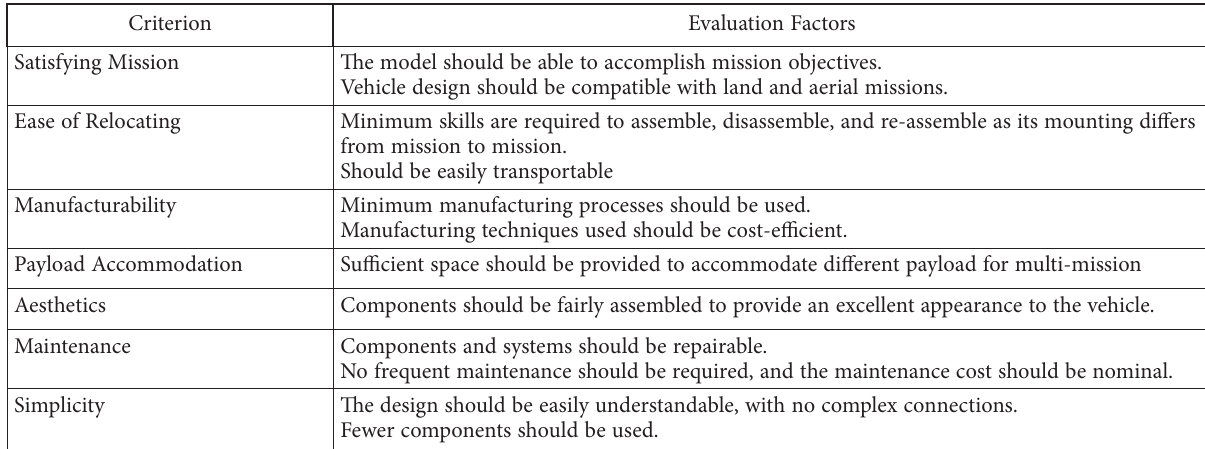
Table A4. Design criterion and evaluation factors